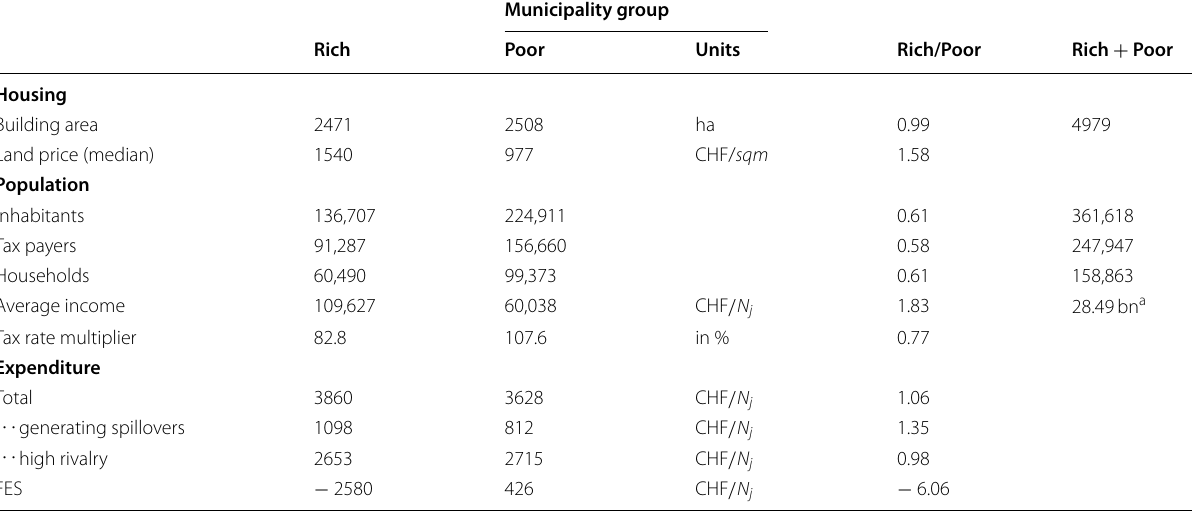
Table 2 Summary statistics for the groups of municipalities around the city center of